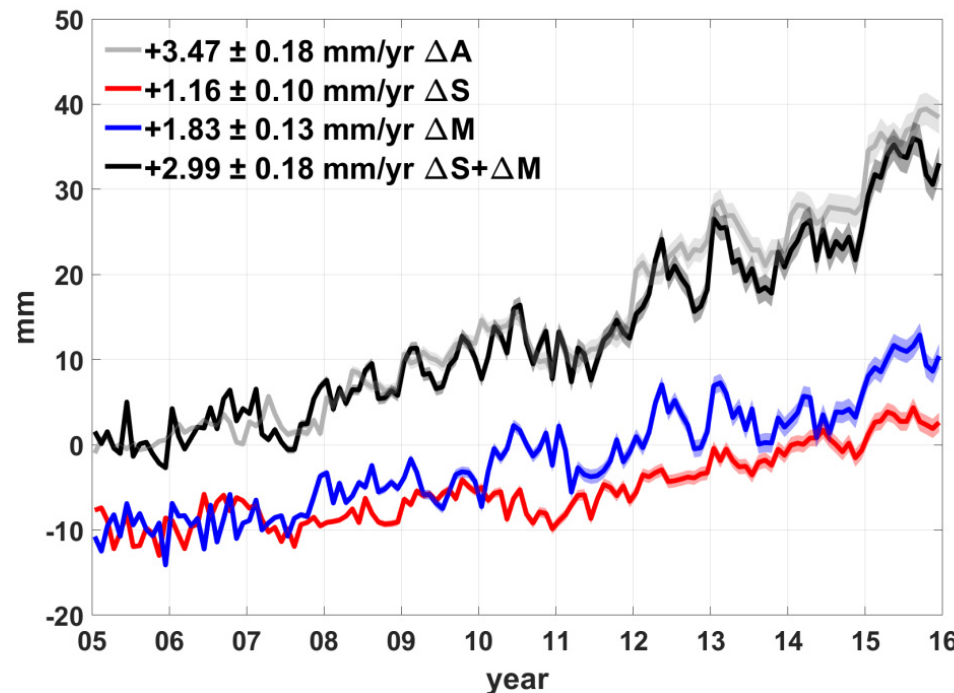
Figure 2. Ensemble mean of sea level change estimates of altimetry ( Δ A, gray curves), Argo steric ( Δ S, red), and GRACE Mascons ( Δ M, blue). The sum of Δ S and Δ M contributions are presented with a black solid curve. The computations are based on Equations (2)–(4) with respect to individual data domains as provided, and the detailed evaluation is listed in Table 1. The trends are estimated by using linear regression after removing seasonal variations. Error boundaries are given at 95% confidence level, shown as shaded plots along with the corresponding curves. Red and blue curves include negative offsets ( − 10 mm) for clarity.